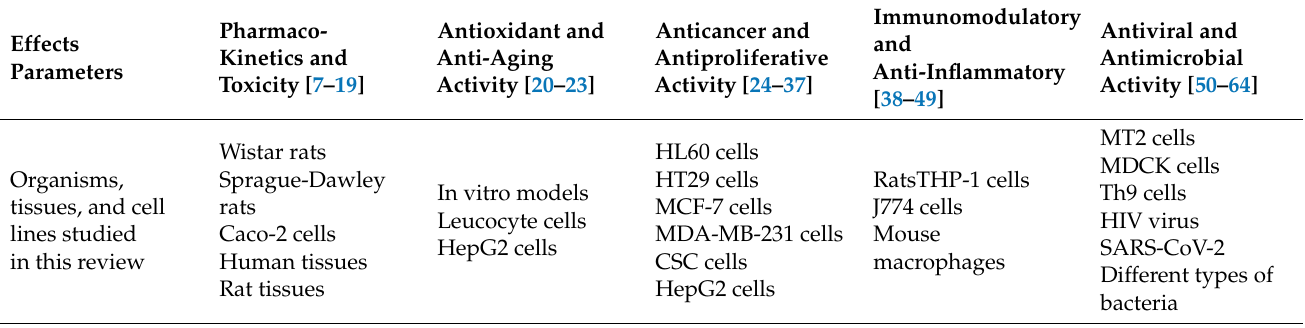
Table 1. Main molecular markers that initiate in the bioactivities of the different polyphenols present in olive extracts and the target cells in which they are